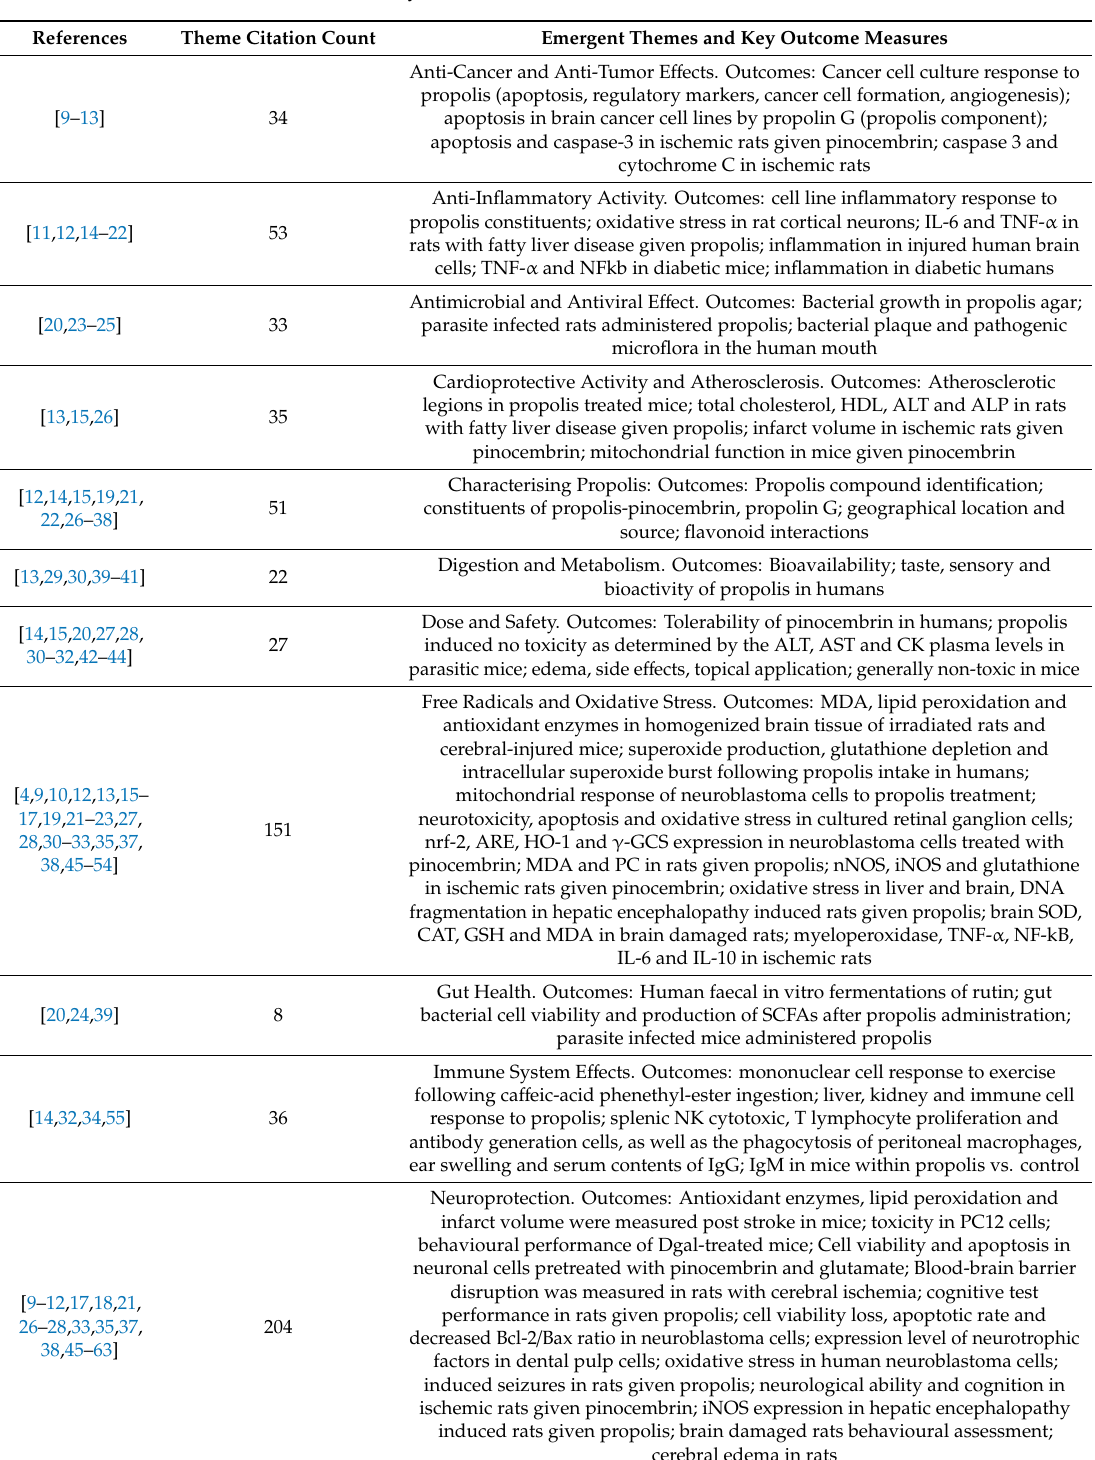
Table 1. Summary of included studies derived for each